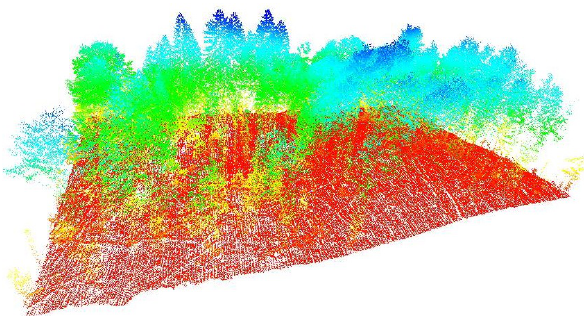
Figure 6: Point cloud of Plot B colored by height over